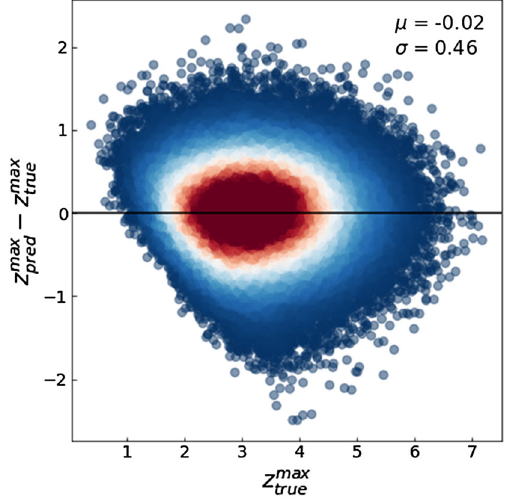
Fig. 2 The difference between z max and z max true as a function of z max true . pred Dense regions are shown in red (roughly corresponding to the 1 σ region), while sparse regions are shown in blue